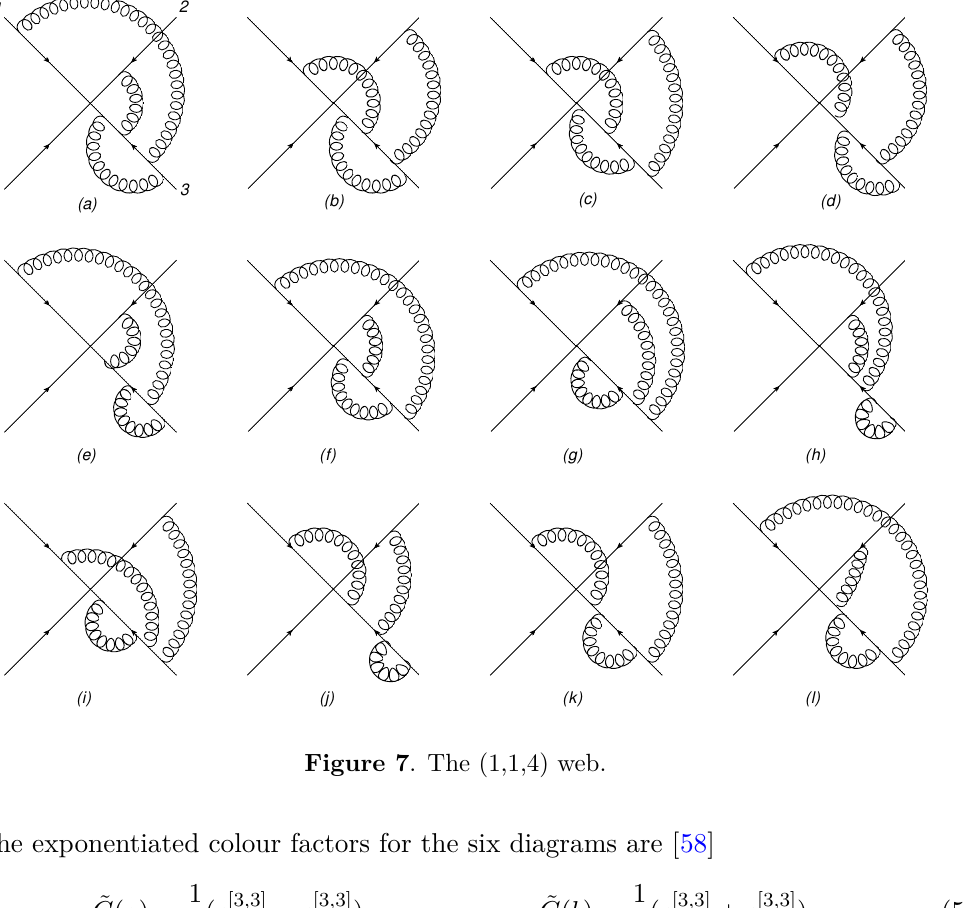
Figure 7 . The (1,1,4)